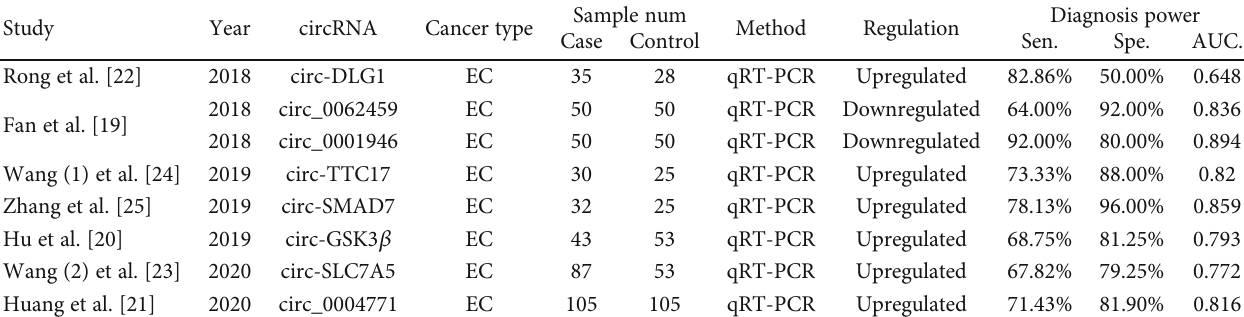
Figure 1: The fl owchart of research selection. Table 1: Main characteristics of studies for diagnosis